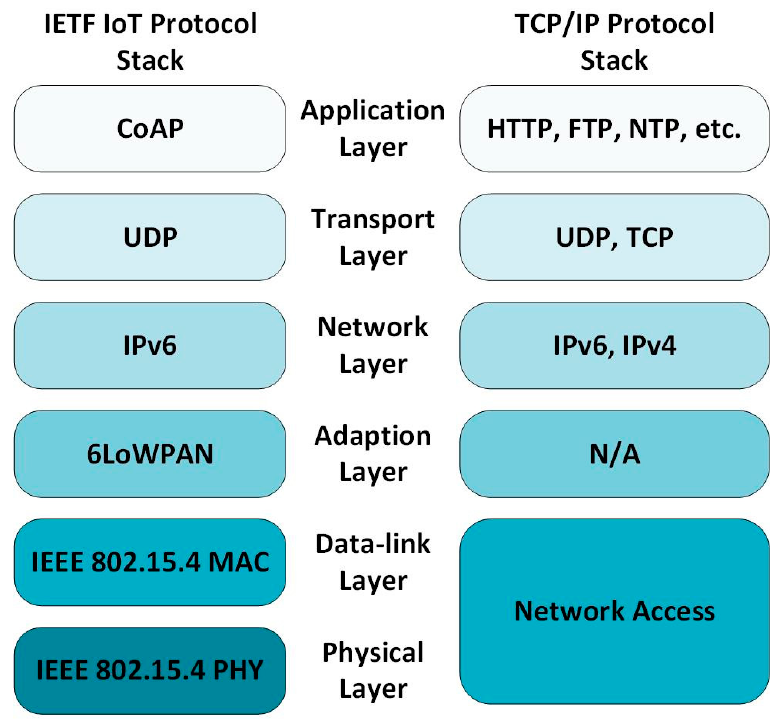
Figure 2. IETF protocol stack for IoT ( left ) and TCP/IP stack ( right